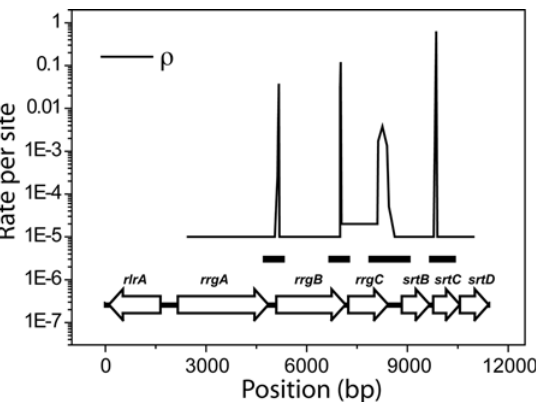
Figure 5. Recombination Rate. Plot of the recombination rate r per base pair along the sequence. Also shown are the positions of the ORFs. The recombination hotspots, represented by the peaks in r , are closely associated with the intergenic regions. Due to the low level of sequence divergence, r is not computed in the region encoding for the rlrA transcriptional regulator. The dark intervals mark the positions of 4 recombination hotspots predicted using sequenceLDhot, which are in good agreement with the positions of the peaks of r